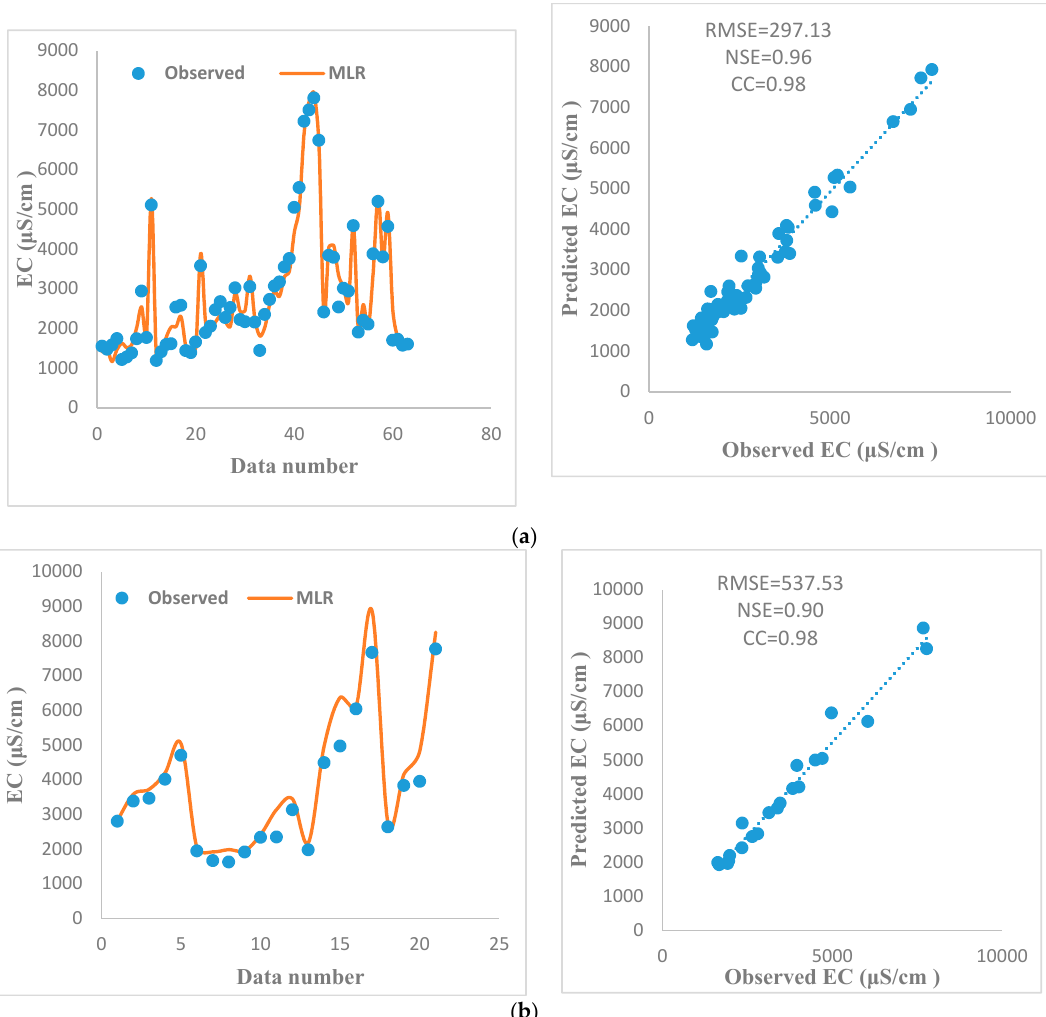
Figure 10. Comparative plots of observed and predicted EC values using MLR model for ( a ) calibration data set and ( b ) validation. Hydrology 2019 , 6 , x FOR PEER REVIEW